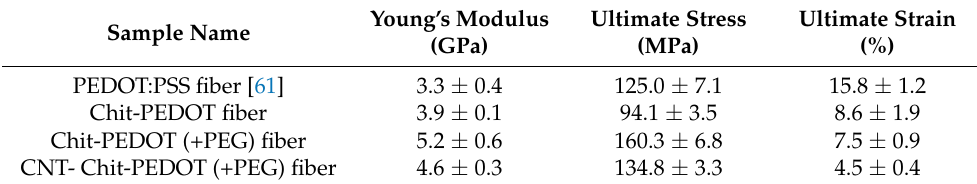
Table 3. Mechanical properties of coaxial and triaxial